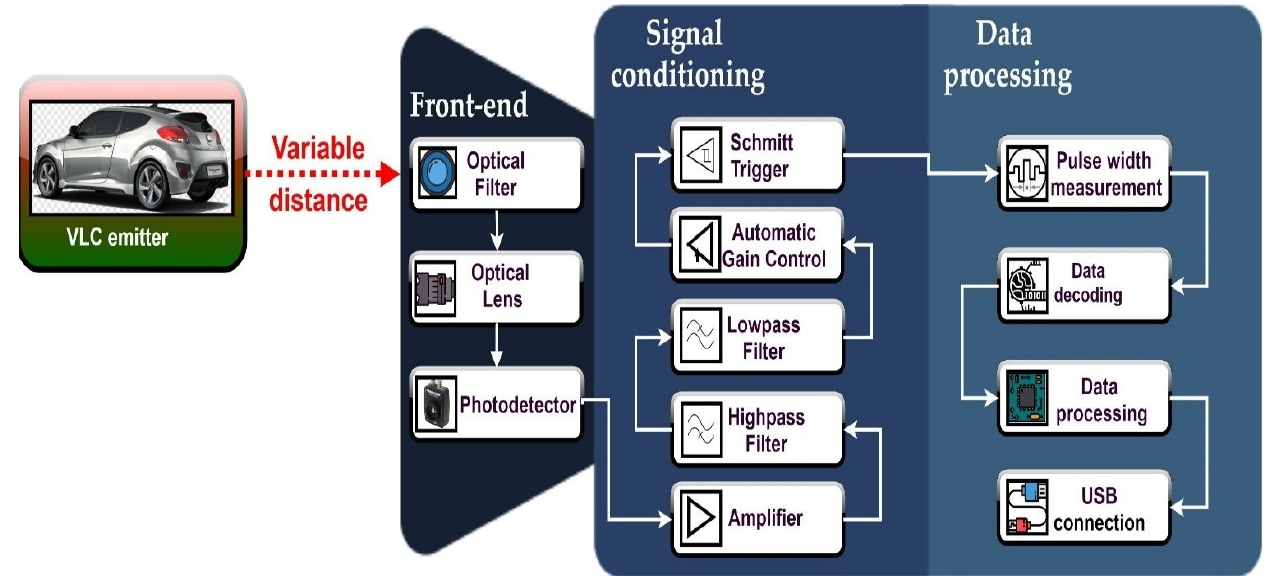
Figure 6. Schematic representation of the VLC system.